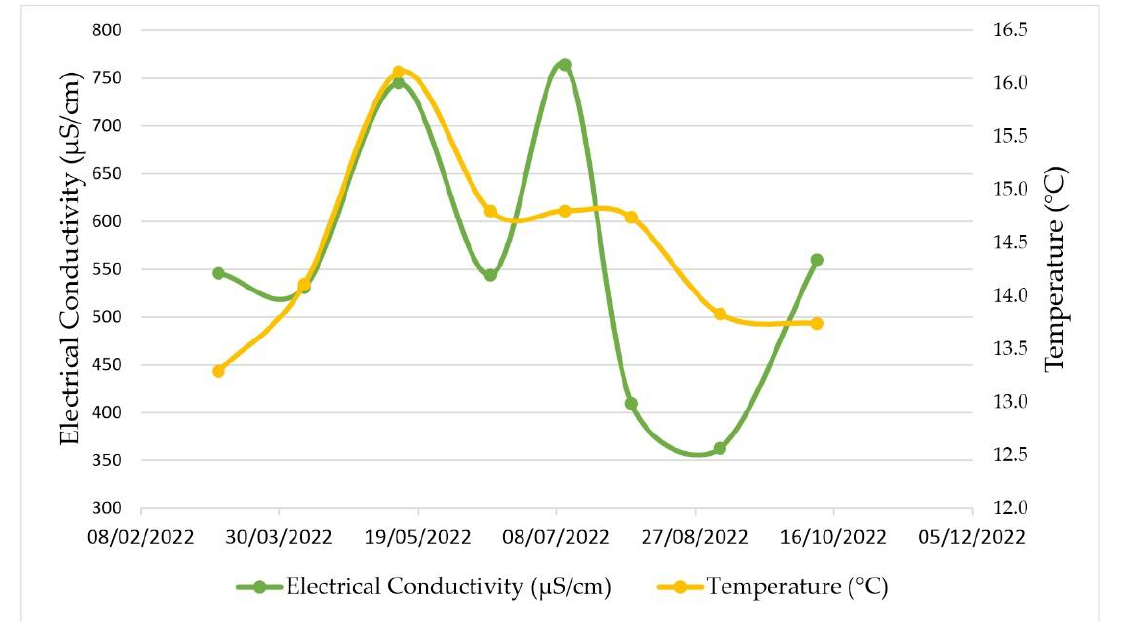
Figure 9. Groundwater EC vs. groundwater temperature in Pz3 (dates are given in day/month/year). Table 2. Results of PCP